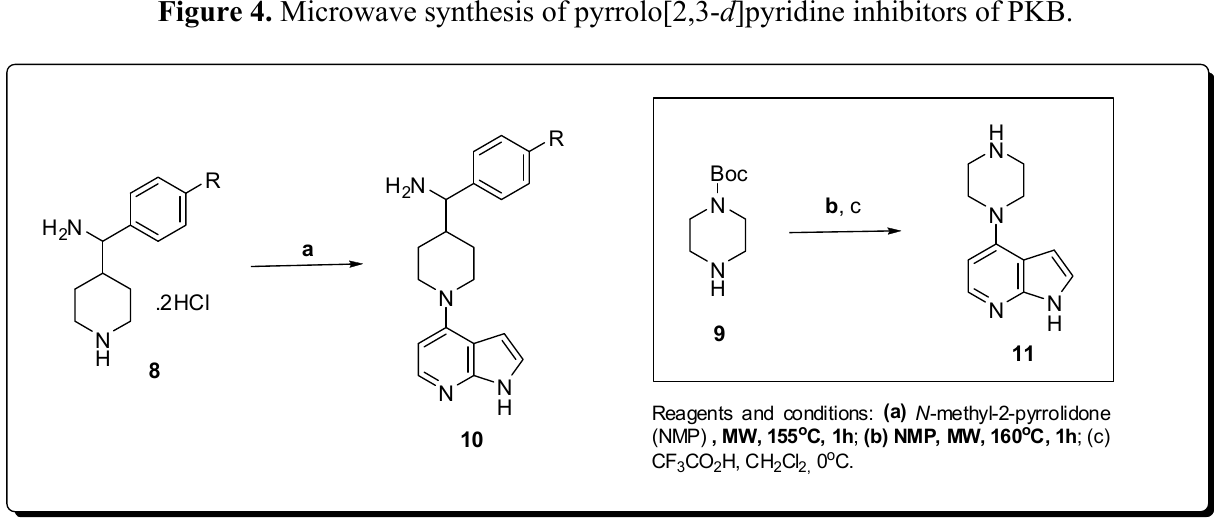
Figure 4. Microwave synthesis of pyrrolo[2,3- d ]pyridine inhibitors of